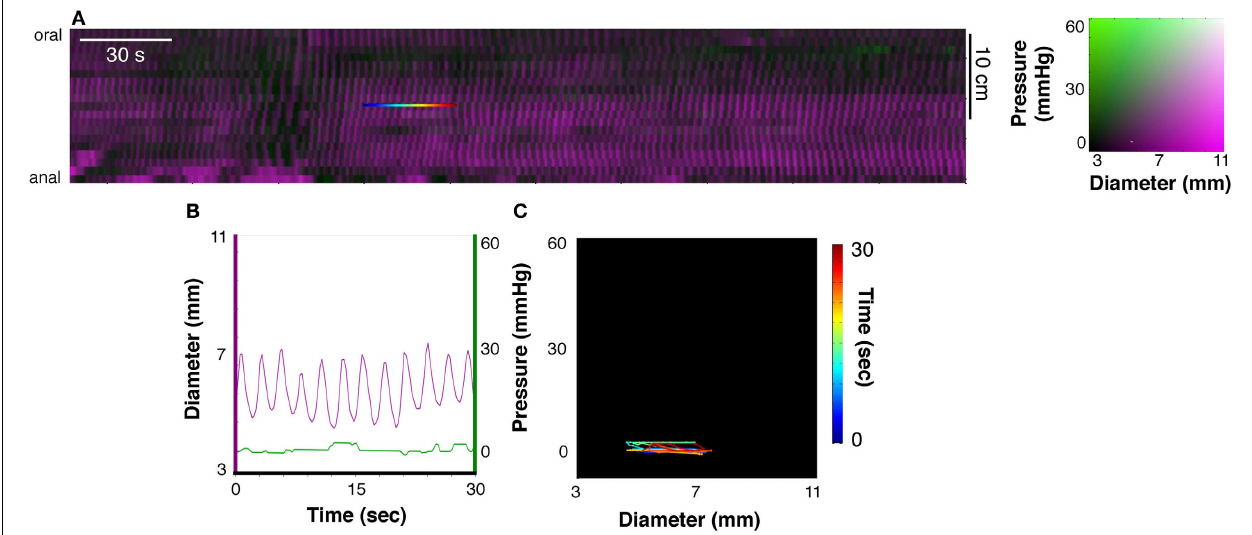
taken from the rainbow-colored line in (A) . In this example the myogenic activity consists of low-amplitude, rhythmic changes in gut diameter [magenta line in (B) , with minimal effect on intraluminal pressure see B ]. When plotted against each other, these give rise to flat orbit plots with short excursions in (C)